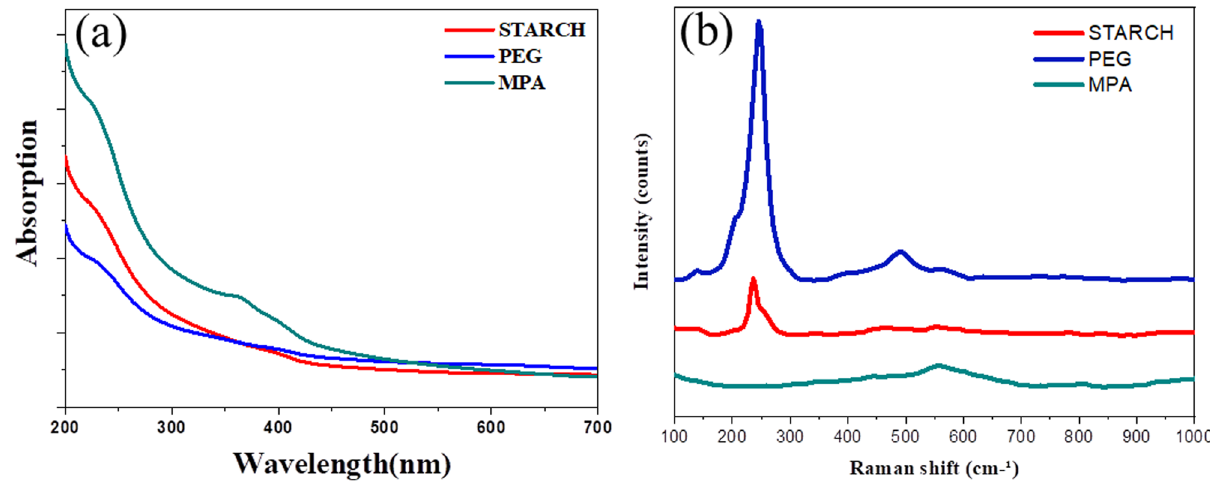
Figure 1: UV - Vis absorbance ( a ) and ( b ) Raman spectra of ZnSe:Mn using various capping